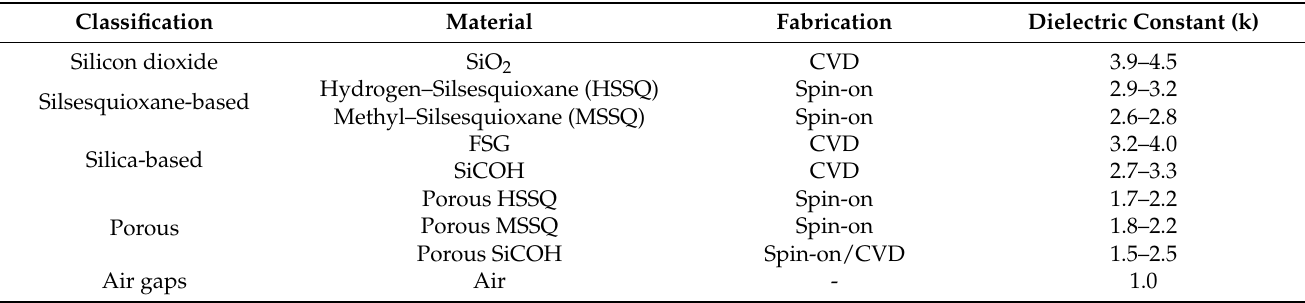
Table 1. Dielectric constants of various contemporary low-k materials [7].